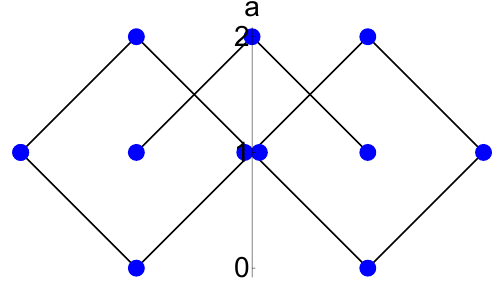
Figure 6 . Homological diagram for 6 2